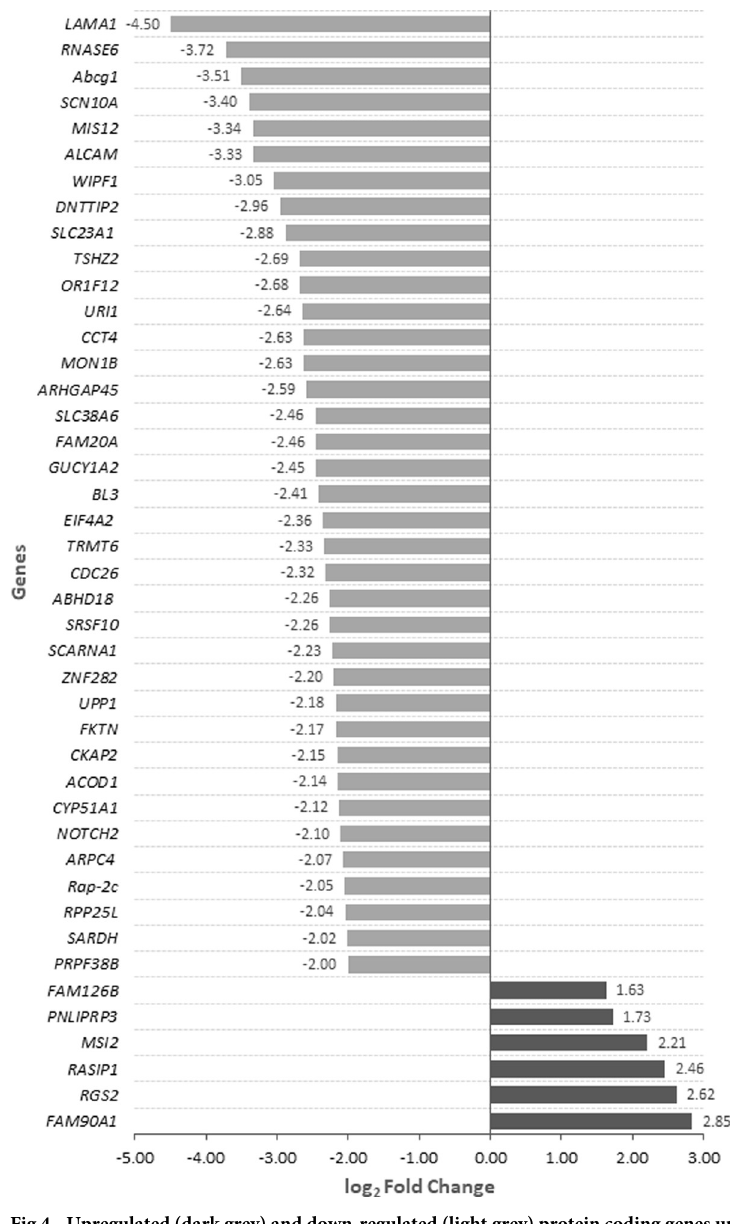
relevant upstream regulators found for the DA genes include enzymes, SIRT3 (activated), and